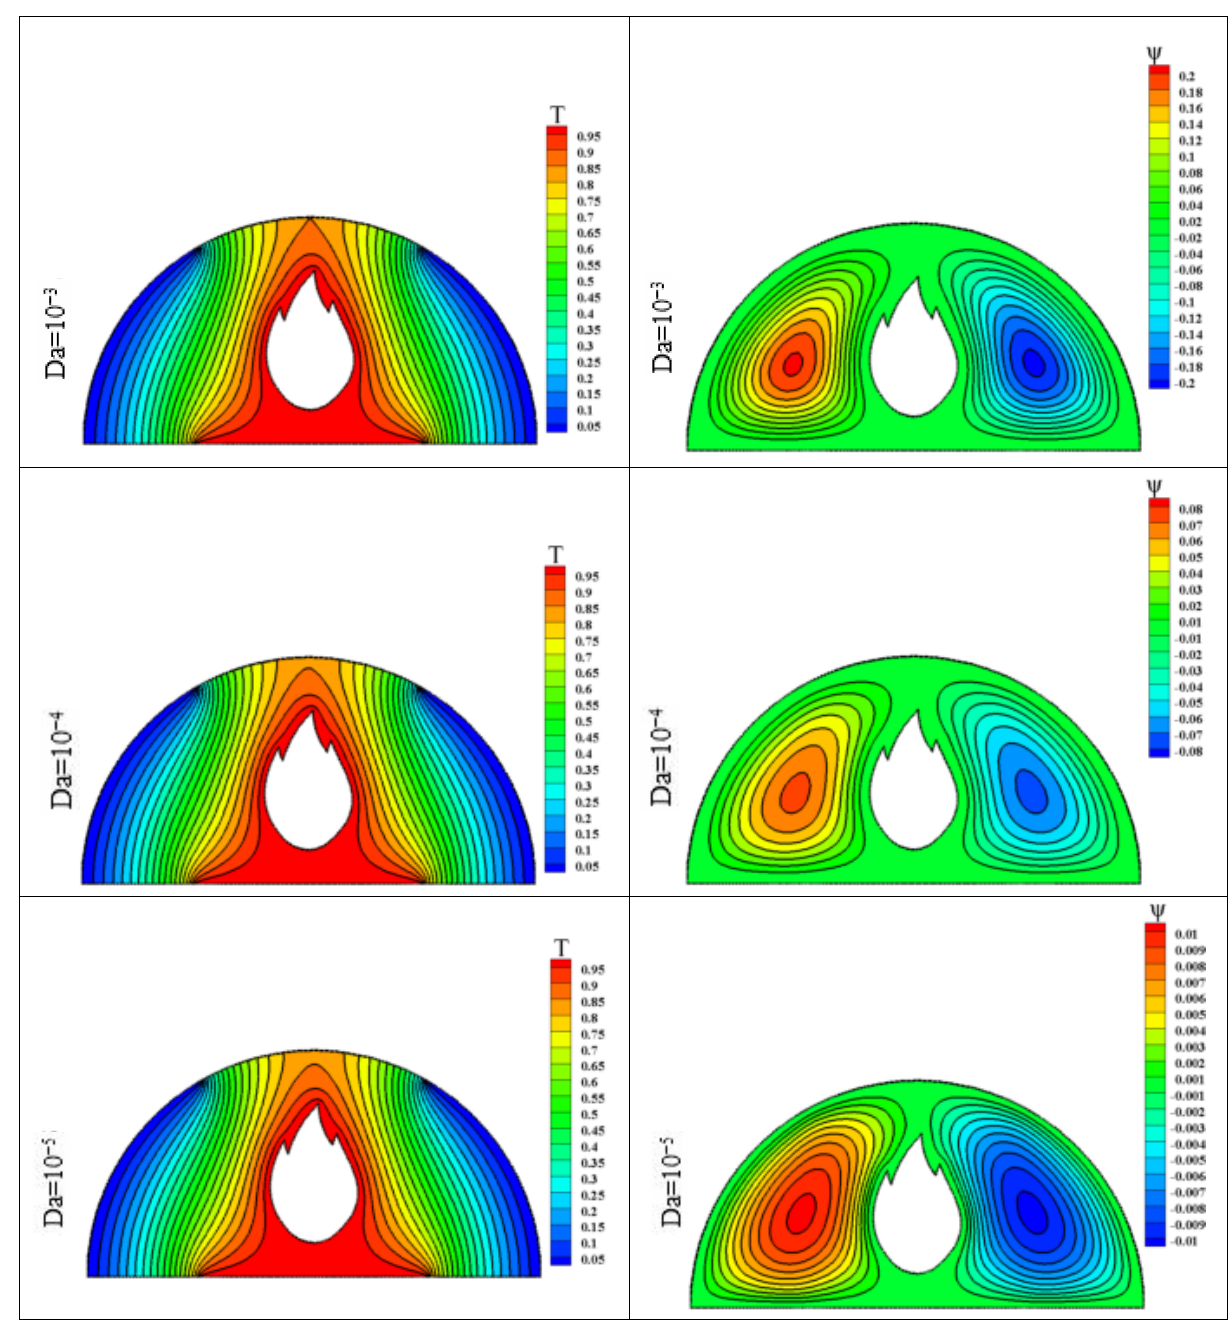
Figure 15. Streamlines ( right ) and isotherms ( left ) inside the enclosure for various values of Da at ( φ = 0.02, L = 0.2, Ha = 50 and Ra = 10 5